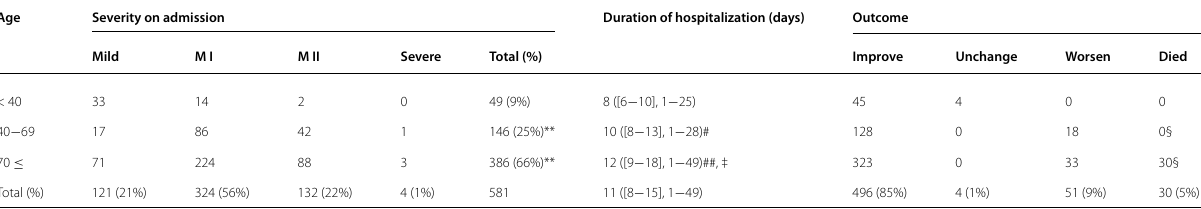
The number of patients is expressed as the absolute value (percentage). The duration of hospitalization is expressed as median days ([25 range) ** P < 0.001 compared with the severity of patients < 40 years and of 40 # P < 0.01 and ## P < 0.001 compared with the duration of hospitalization of patients < 40 years ‡ P < 0.001 compared with the duration of hospitalization of patients of 40 § P < 0.001 compared with the outcome of patients < 40 years and of 40